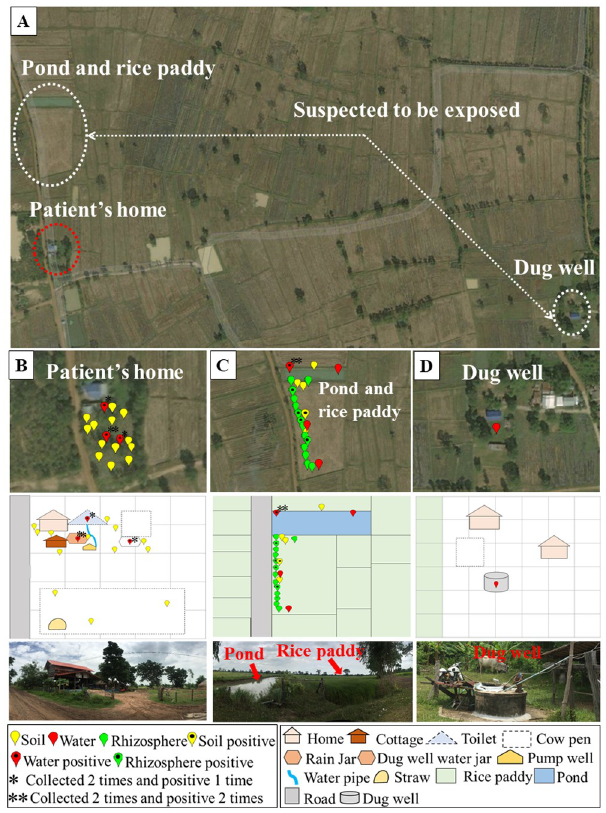
Fig 2. Geographic location of the sampling sites and points. (A) The locations at which the patient was suspected to be exposed (suspected to be exposed), the patient’s house (patient’s house) and the community-dug well used by the patient and community for drinking and cooking (dug well). (B) The pins denote the sampling points for the locations near the patient’s house. (C) The pins denote the sampling points around the pond and the rice paddy field to which the patient was suspected to be exposed. (D) The pins denote the water samples and the enclosed area surrounding the dug well. The sampling points were tracked using GPSMAP 60CSx, and the map was created using LandsatLook Viewer (http://landsatlook.usgs.gov/). Pins with black spots represent B . pseudomallei culture-positive